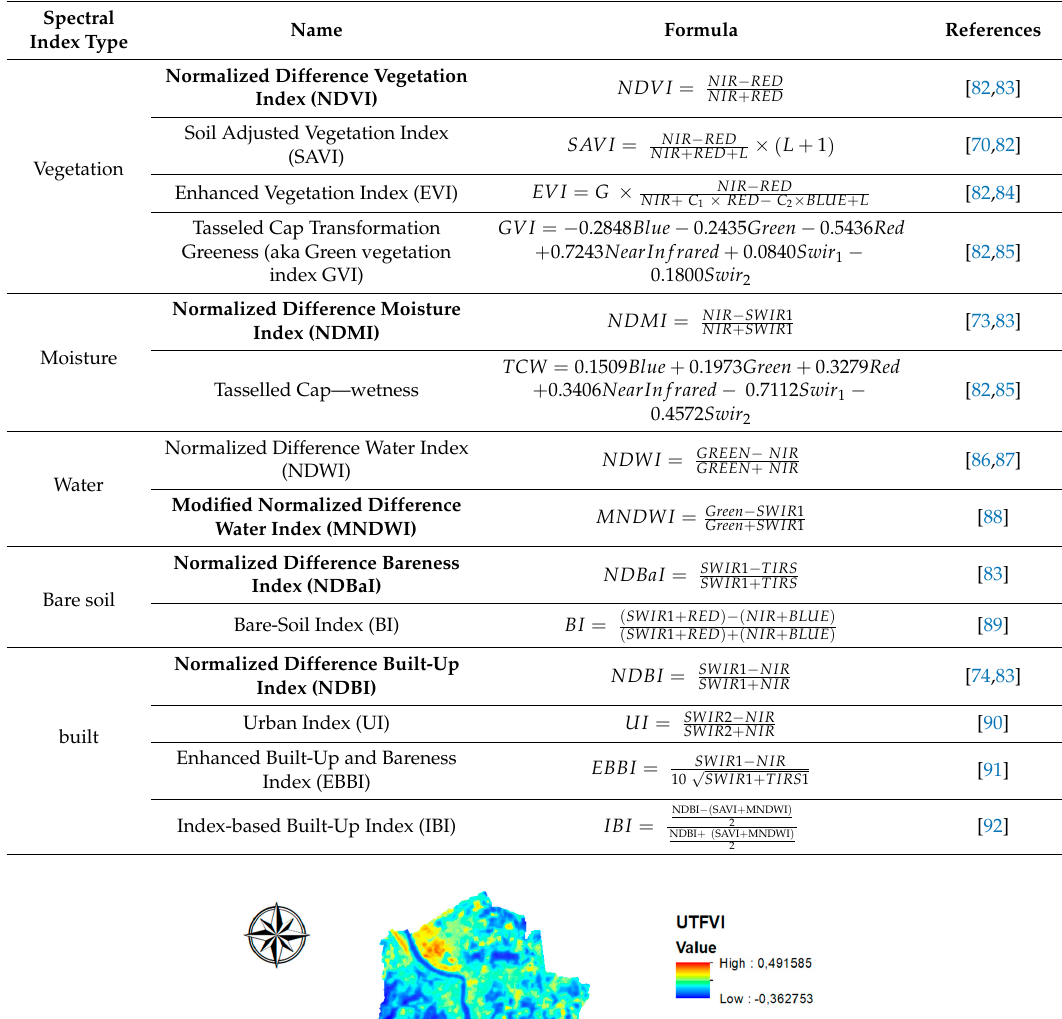
Table 3. Spectral indices (selected indices are shown in bold).